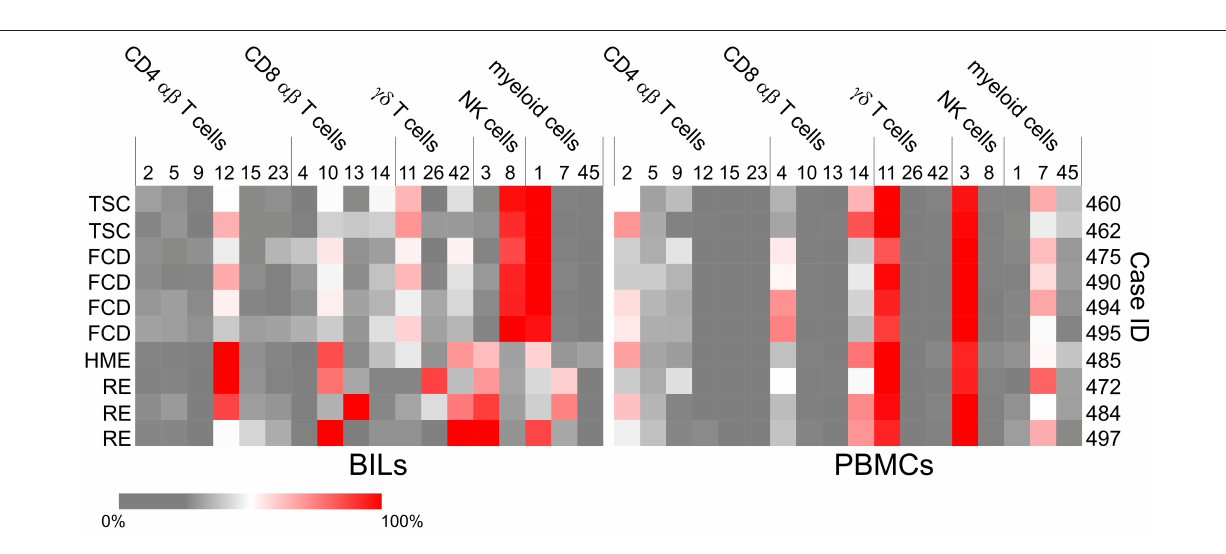
FIGURE 5 | Heat maps showing the subsets of T cells, NK and myeloid cells that account for the majority of lymphoid and myeloid cells in each BILs and PBMC fraction. The heat maps show the relative abundance of each cluster as a percentage of the total number of CD4 αβ T cells, CD8 αβ T cells, γδ T cells, NK cells or myeloid cells, respectively in each BIL and PBMC fraction ( Table S4